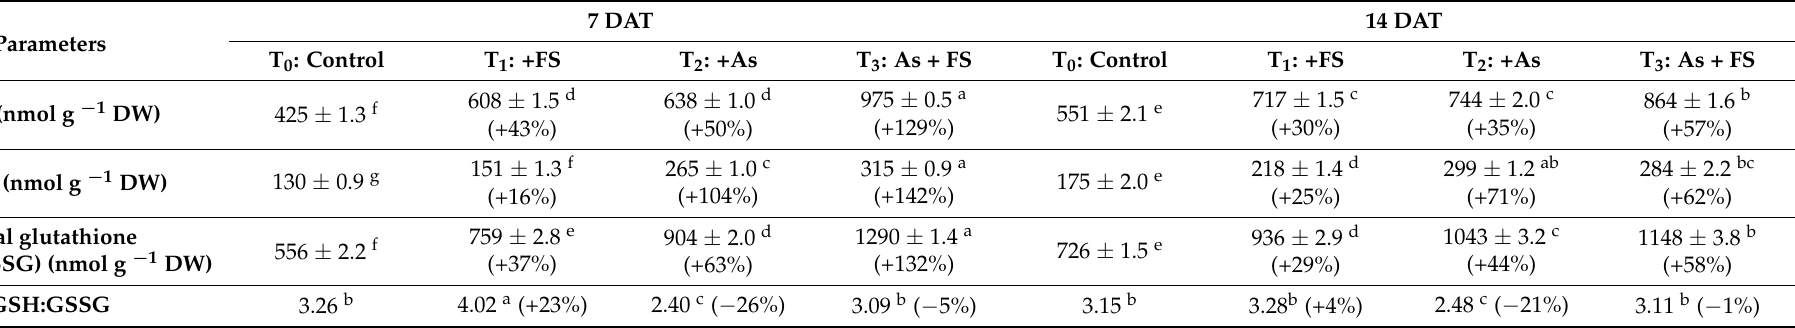
Table 2. Impact of iron sulfate (T 1 : +FeSO 4 ), arsenic stress (T 2 : +As) and iron sulfate supplementation during As stress (T 3 : As + FeSO 4 ) on contents of glutathione (GSH), oxidized glutathione (GSSG), total glutathione (GSH + GSSG) and the ratio of GSH:GSSG in the leaf of Brassica juncea studied 7 and 14 days after treatment (DAT). 7